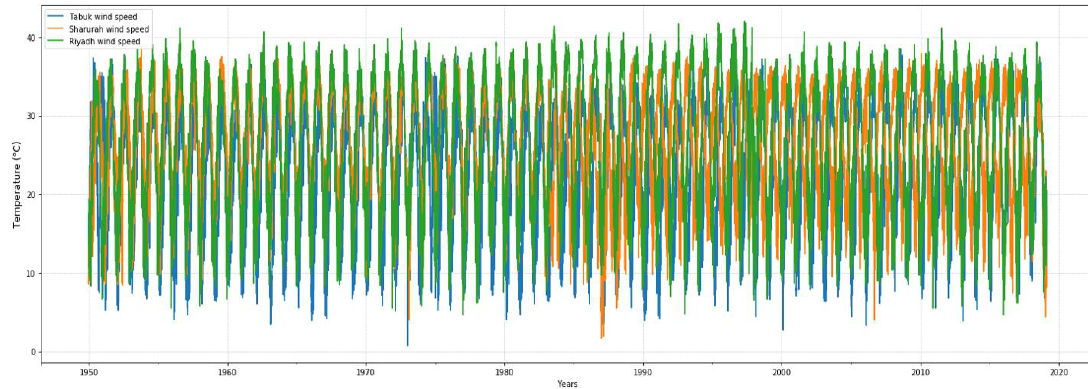
Figure 5. The average temperature performance of the three regions.